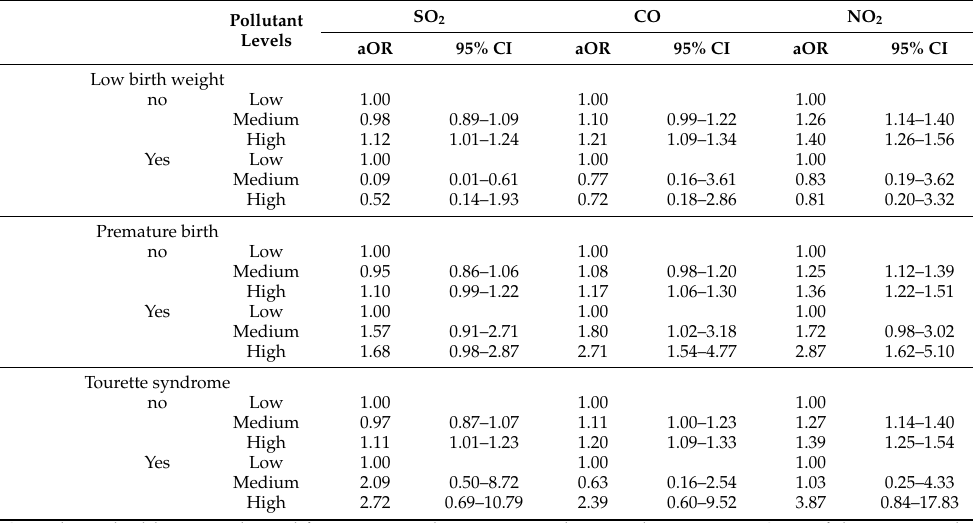
Table 2. Adjusted odds ratios for development delays stratified by low birth weight, premature birth, and Tourette